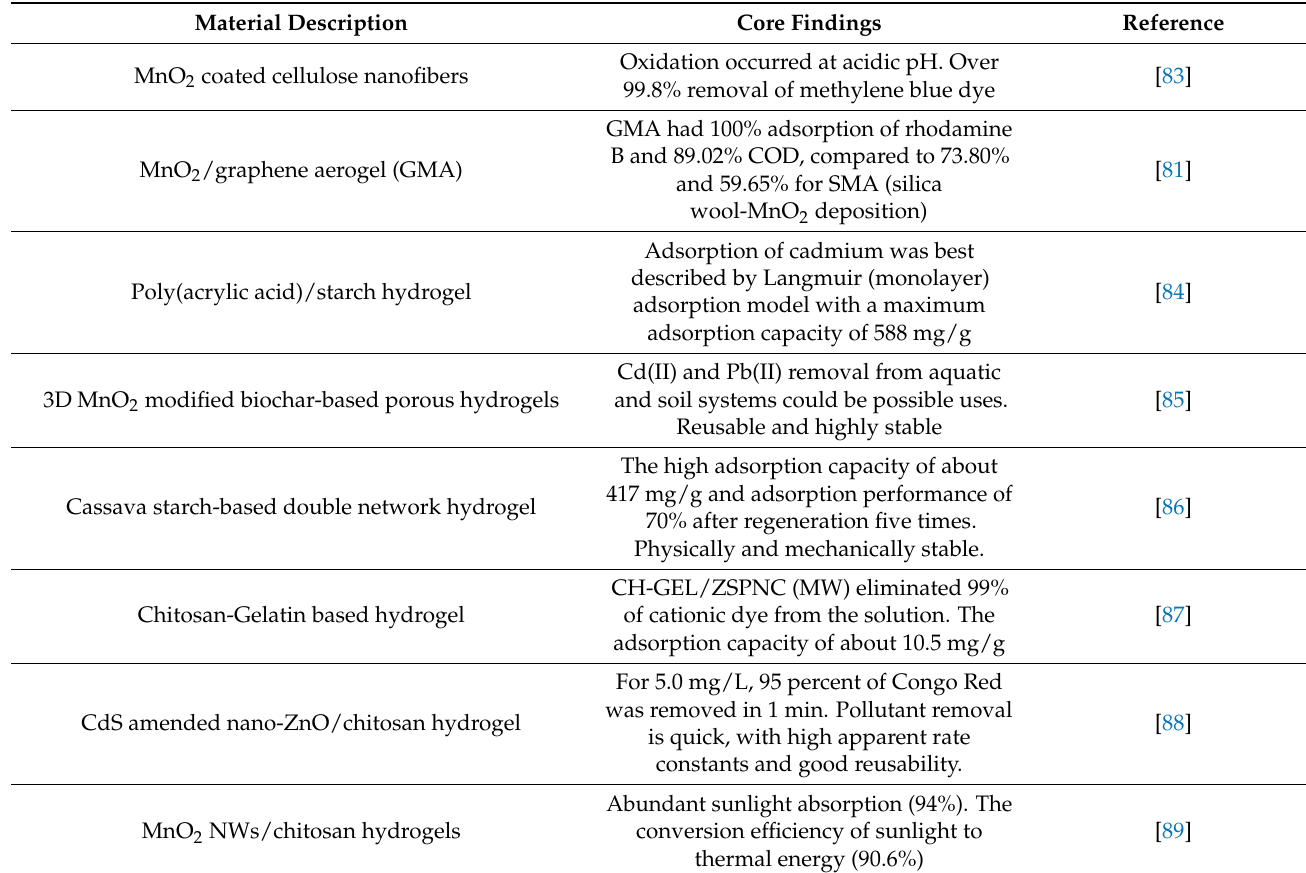
Table 2. Selected hydrogel/aerogel nanocomposites for water treatment